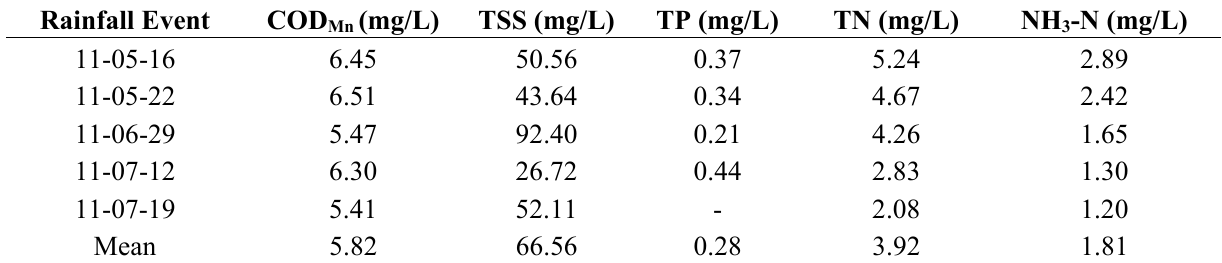
Table 4. The mean concentration of NPS pollution in flood events.